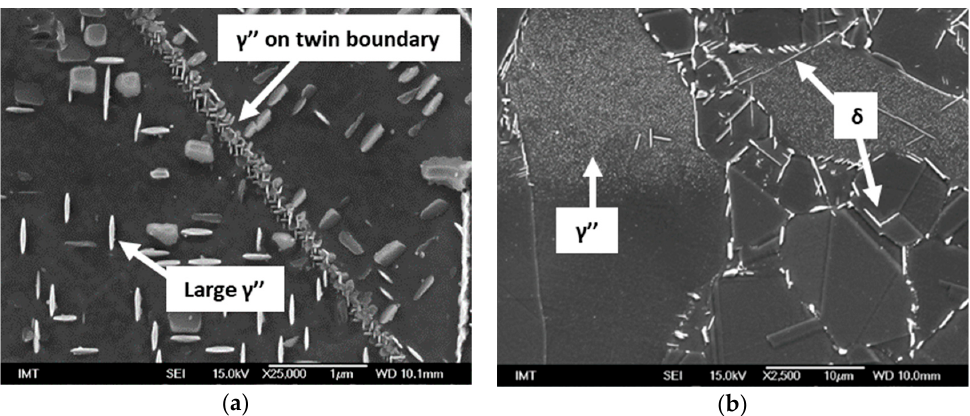
Figure 14. Large γ ’’ precipitates and smaller ones along the twin of the sample hot rolled at 1050 °C with the deformation level of 23.5% and aged at 750 °C for 25 h ( a ). The transition from segregation band in the sample hot rolled at 1150 °C with the deformation level of 25.2% and aged at 750 °C for 125 h ( b ).